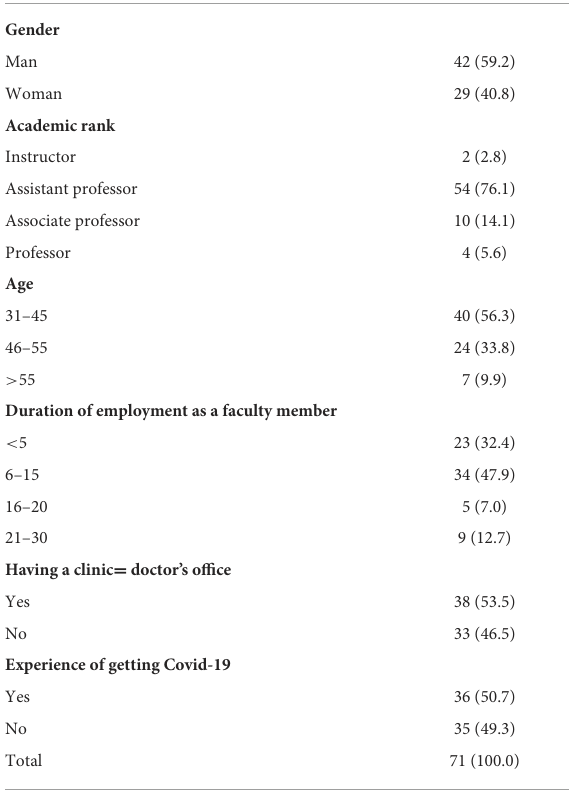
TABLE 1 Demographic characteristics of faculty